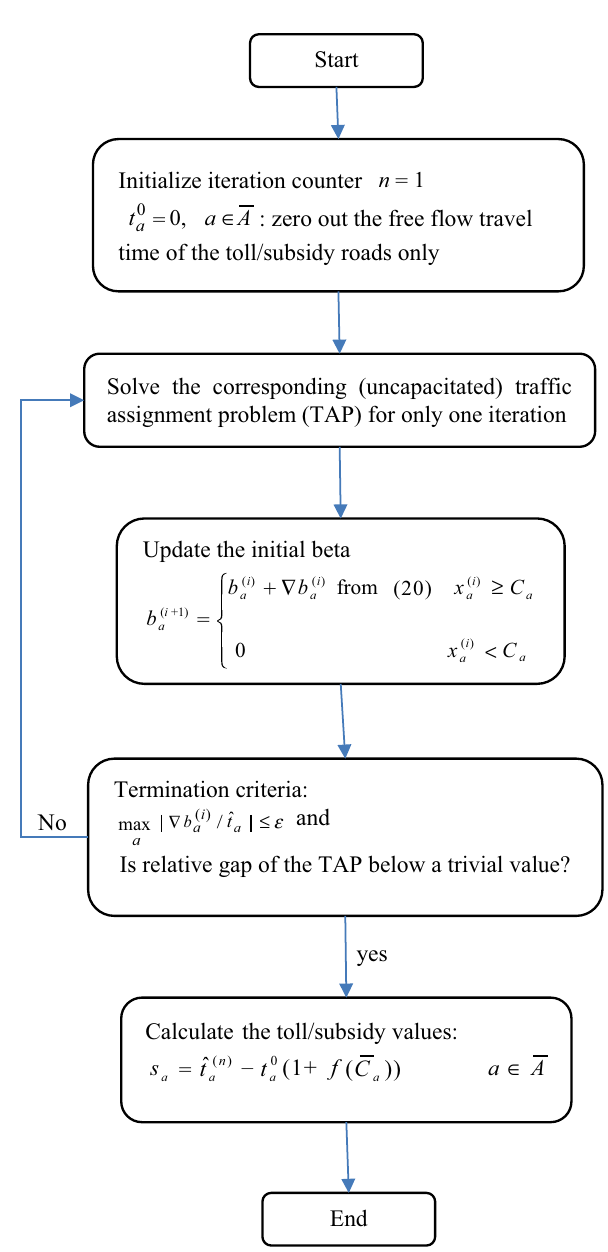
Fig. 2 Flowchart of the proposed methodology for the toll/subsidy pricing. Note that the only loop forwarded to the second block in the flowchart (where it says ‘‘Solve the corresponding (un-capacitated) traffic assignment problem (TAP) for only one iteration’’) is repeated until the corresponding TAP converges to a trivial relative gap. In other words, that does not mean the TAP is solved only for one iteration. In fact, it means a lot more iterations while being paused to provide an opportunity to update the initial-beta in the subsequent